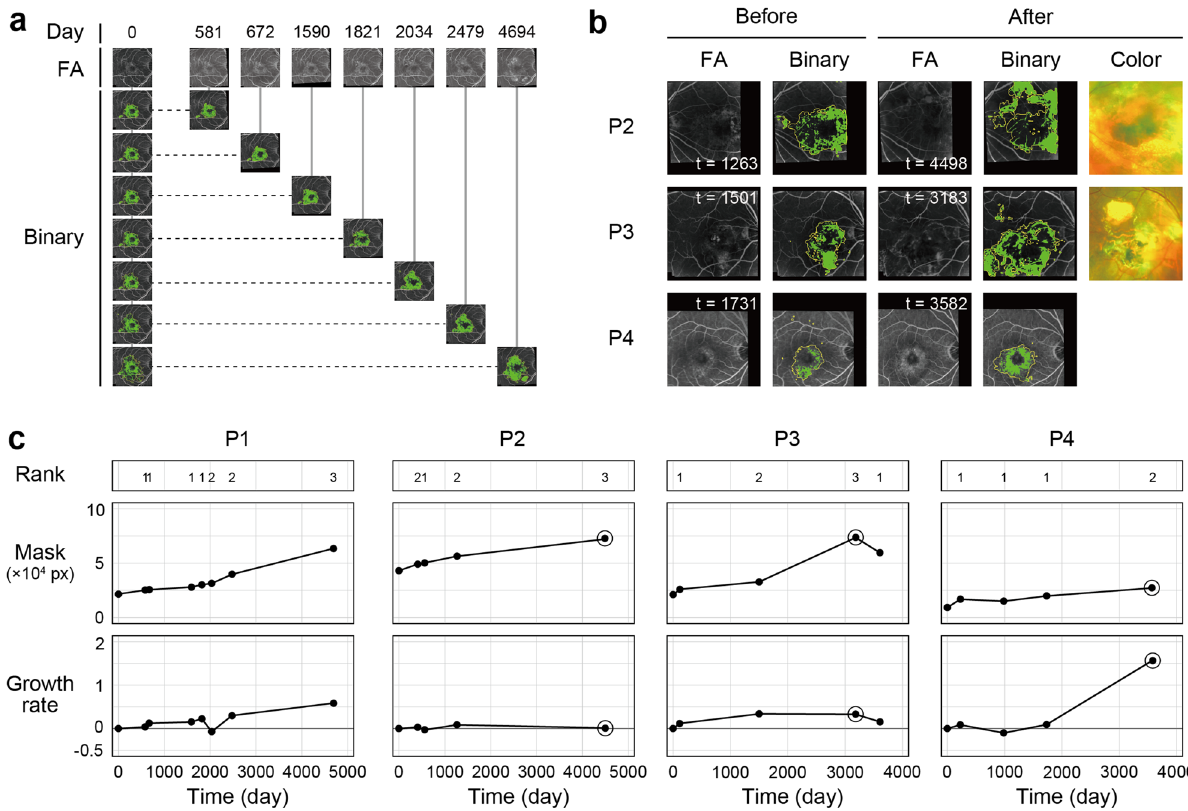
Figure 6. Quantitative assessment of the expanding Hyperfluorescent area over time. Quantitative assessment of the Hyperfluorescent area in four AMD eyes of four patients over 10 years (~ 4694 days). The first image acquisition was defined as day 0. ( a ) Representative temporal analysis of Patient 1 (P1). The FA image of each visit was paired with the initial image, aligned, and corrected for brightness by image processing. Binary images were produced within the merged mask frames of the initial and at each time point as Abnormal regions (yellow frames) predicted by U-Net. Green areas represent areas with Hyperfluorescent Score areas. The Growth rate was calculated between the image of each time point and the initial point. (b) Binary images of the indicated time points with a discrepancy between the mask and Growth rate. Rank 3 points with patients 2 and 3 (P2, P3), and Rank 2 points with patient 4 (P4). The relevant sample is shown in the graph in c, with the points circled. (c) Temporal change in Growth rate of four eyes and the Mask areas (overall Abnormal areas) at each time point. The judgment by two doctors (Rank 1–3) at each time point is also shown for reference. Images of the circled points are shown in ( b